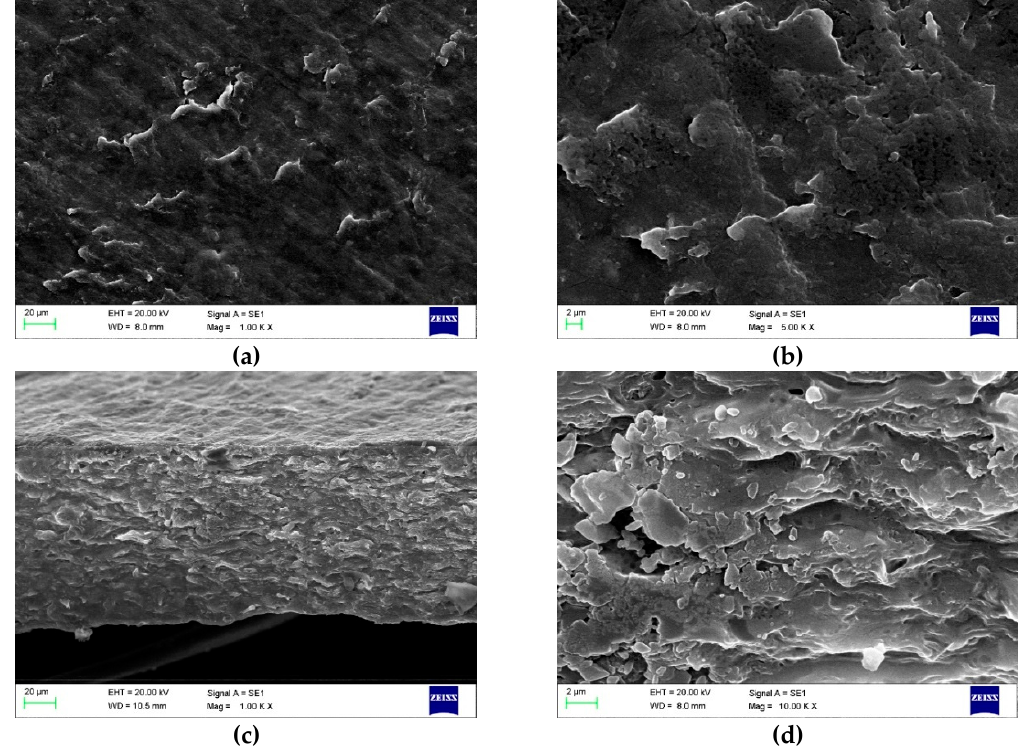
Figure 3 . FE-SEM micrographs of film surfaces with a magnification of 1.00 K × ( a ) and 5.00 K × ( b ) and cross-sectional images with a magnification of 1.00 K × ( c ) and 10.00 K × ( d ) containing the highest concentration of glycerol (14%) prepared according to the sol-gel-ma method (maleic anhydride and sugar concentrations were 0.39% and 7%, respectively).